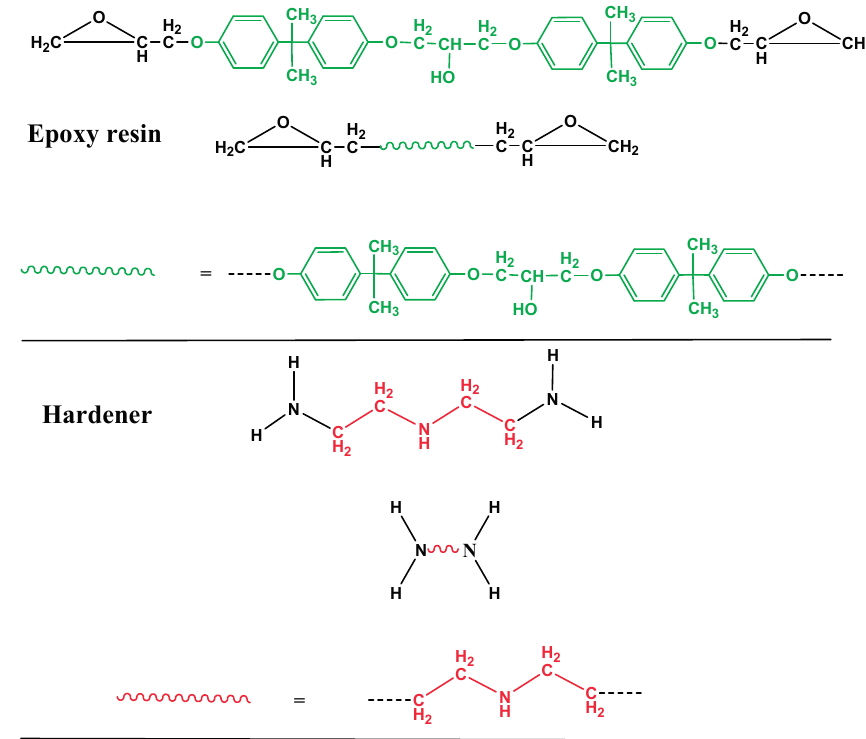
Figure 1. A schematic showing the chemical structure of epoxy and